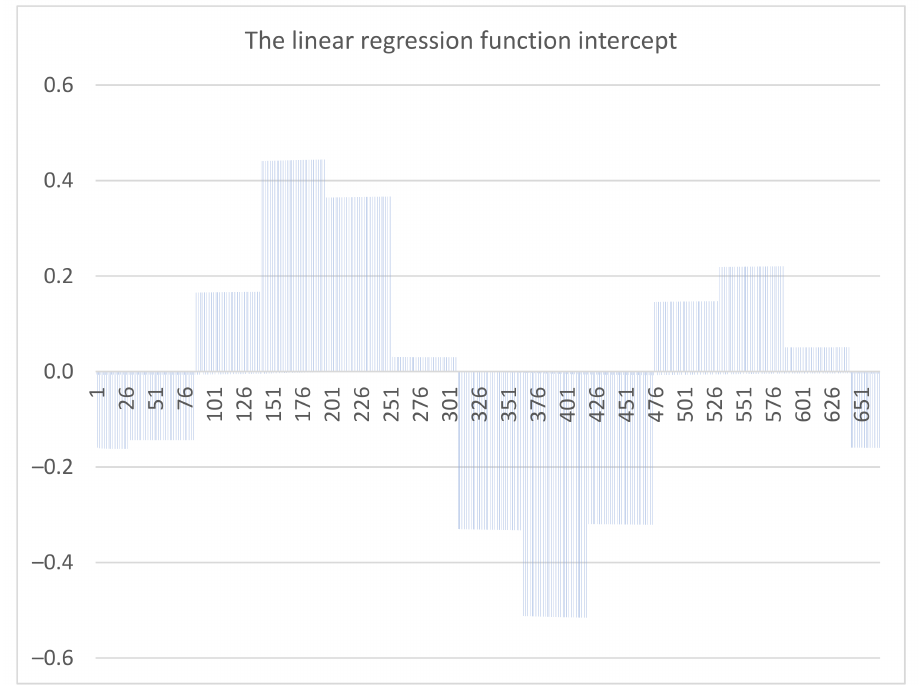
Figure 6. The linear regression function intercept.